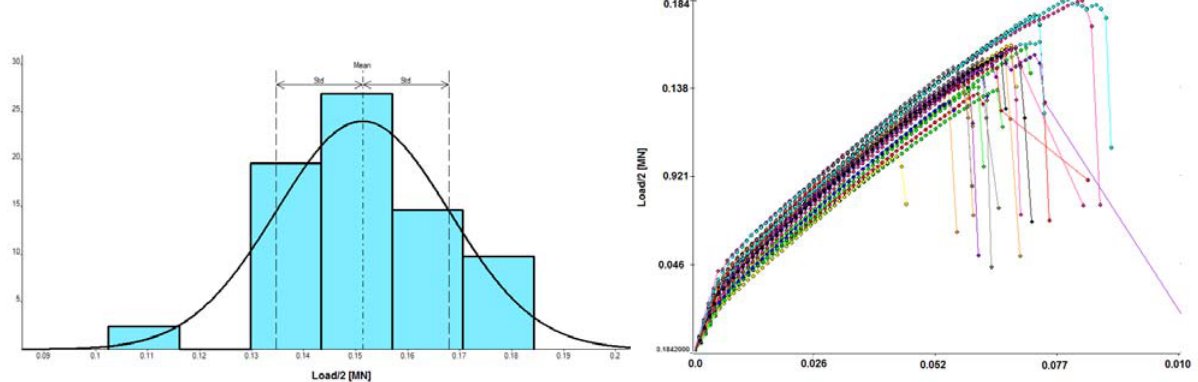
Figure 7: Final histogram, estimate - ultimate load